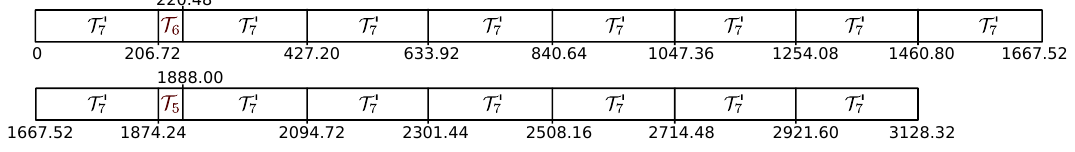
Figure 5. Execution scale of a T1-1 system with 17 MU IEDs (scale unit in µ